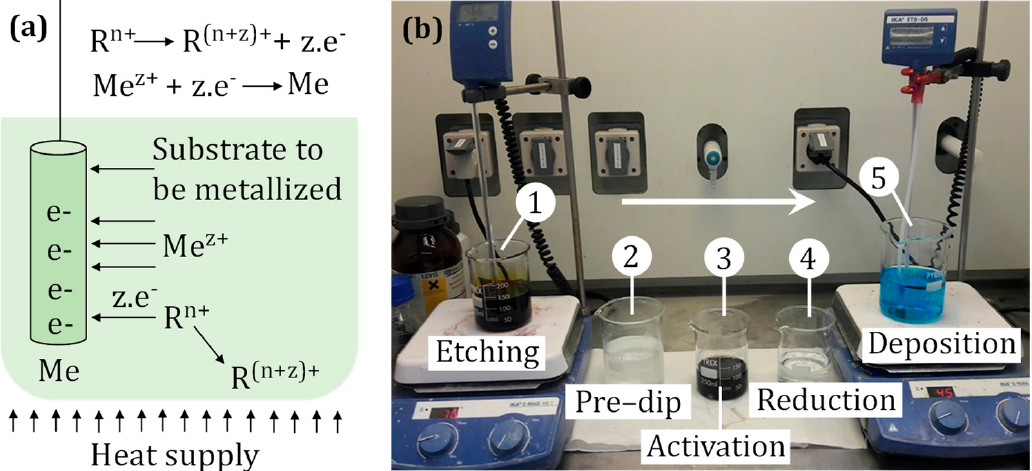
Figure 1. Basic principle of electroless plating—electrons from the surface reduce metal ions from the electrolyte leading to the metal deposition ( a ); the setup used for metallization during the current investigation ( b ).